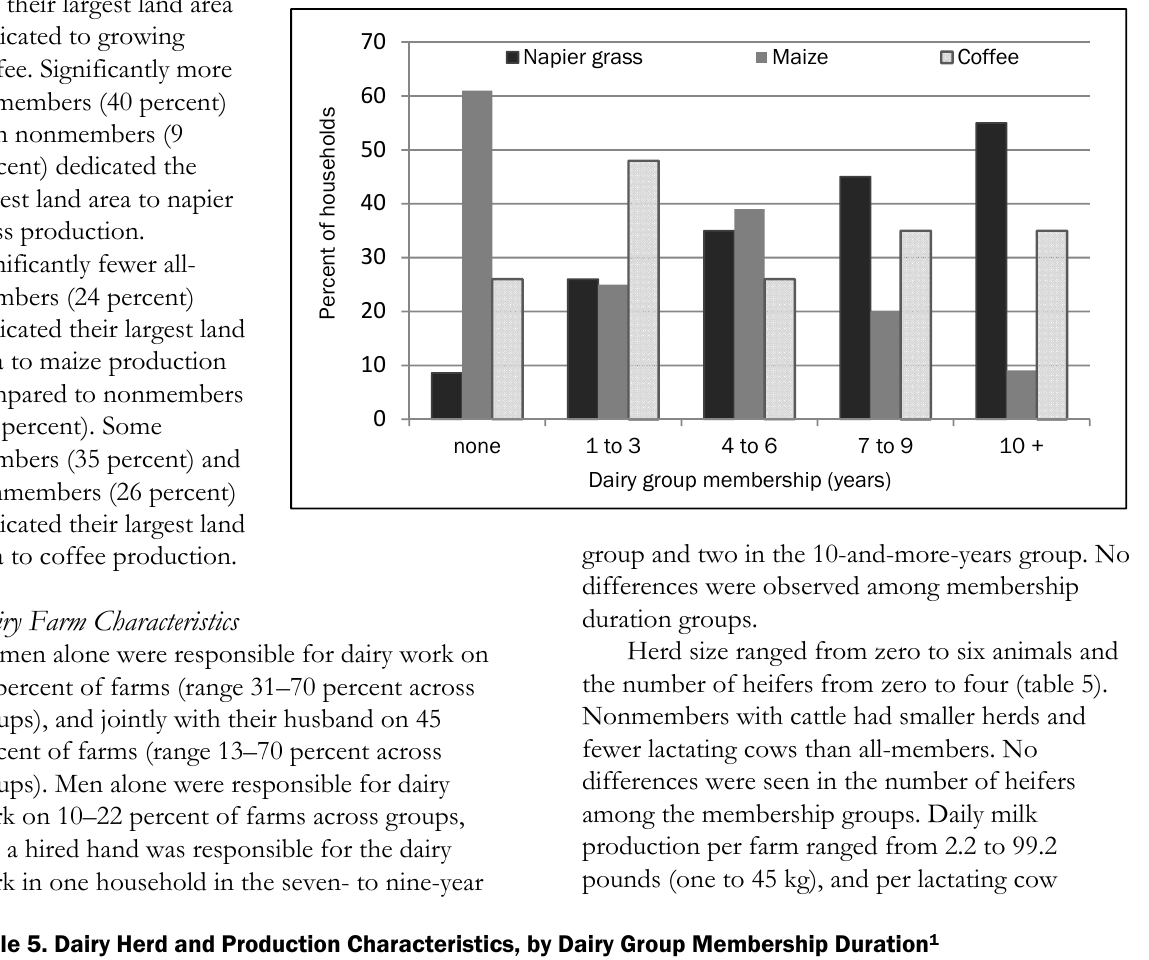
Table 5. Dairy Herd and Production Characteristics, by Dairy Group Membership Duration 1